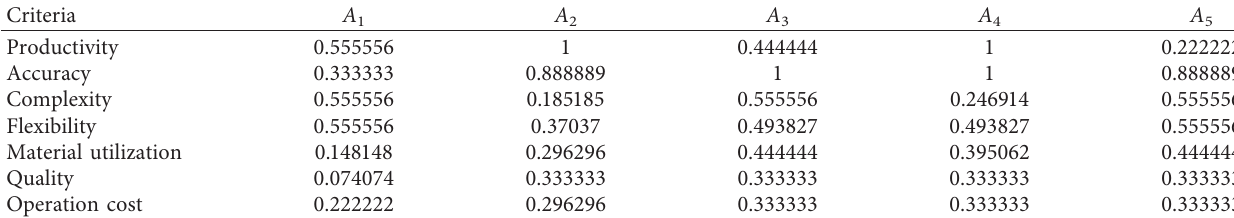
Table 7: Weighted NDM.